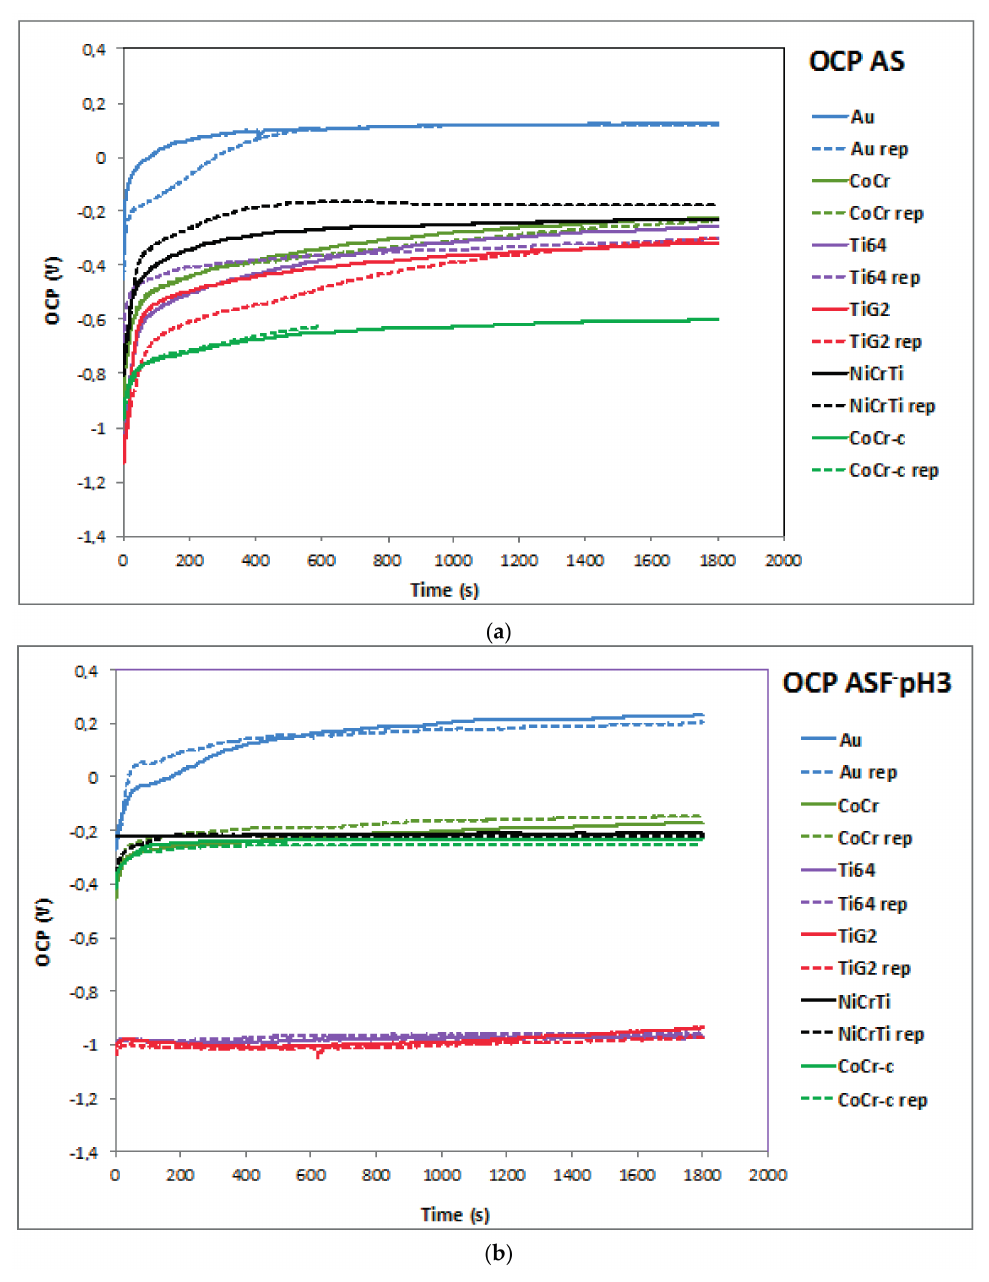
Figure 2. OCP evolution with time of the tested materials in ( a ) AS and ( b ) ASF − pH3. Legend: Au: gold-palladium alloy; CoCr: cobalt-chromium alloy; CoCr-c: cobalt-chromium cast alloy; NiCrTi: nickel-chromium-titanium alloy; Ti64: Titanium-6Aluminium-4Vanadium Titanium alloy); TiG2: Titanium grade 2; rep: repetition of the